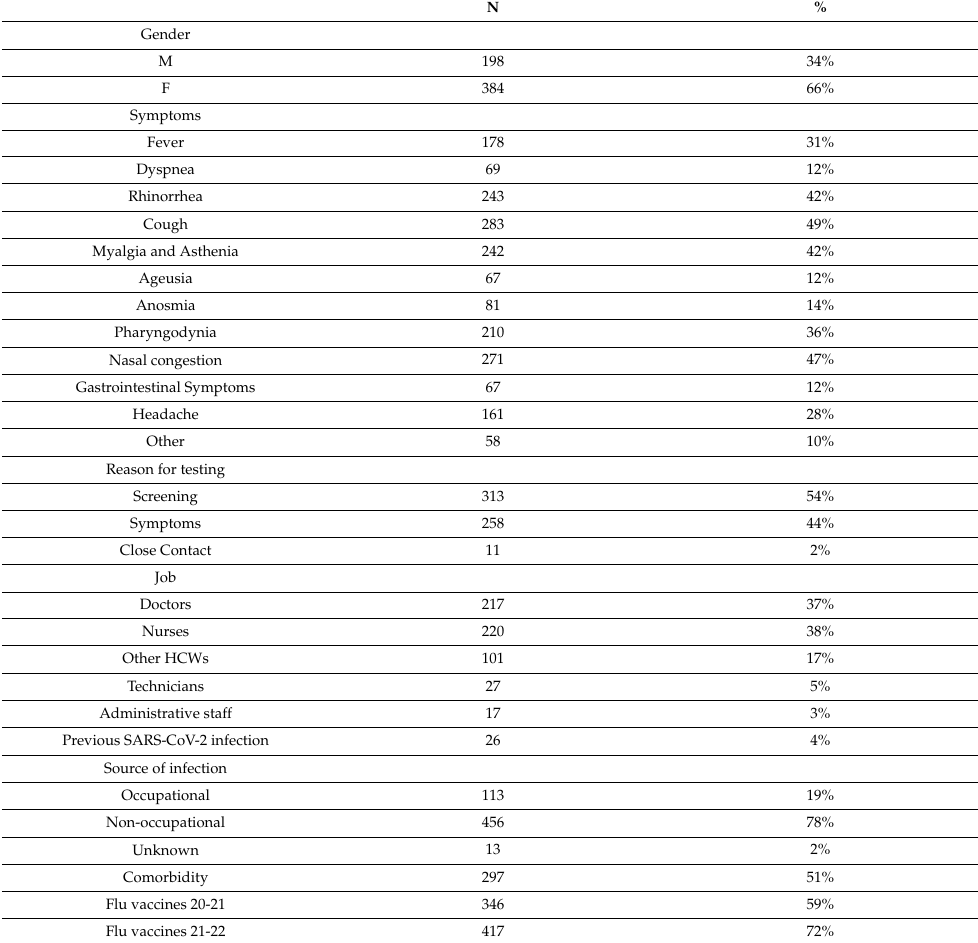
Table 1. Characteristics of BI